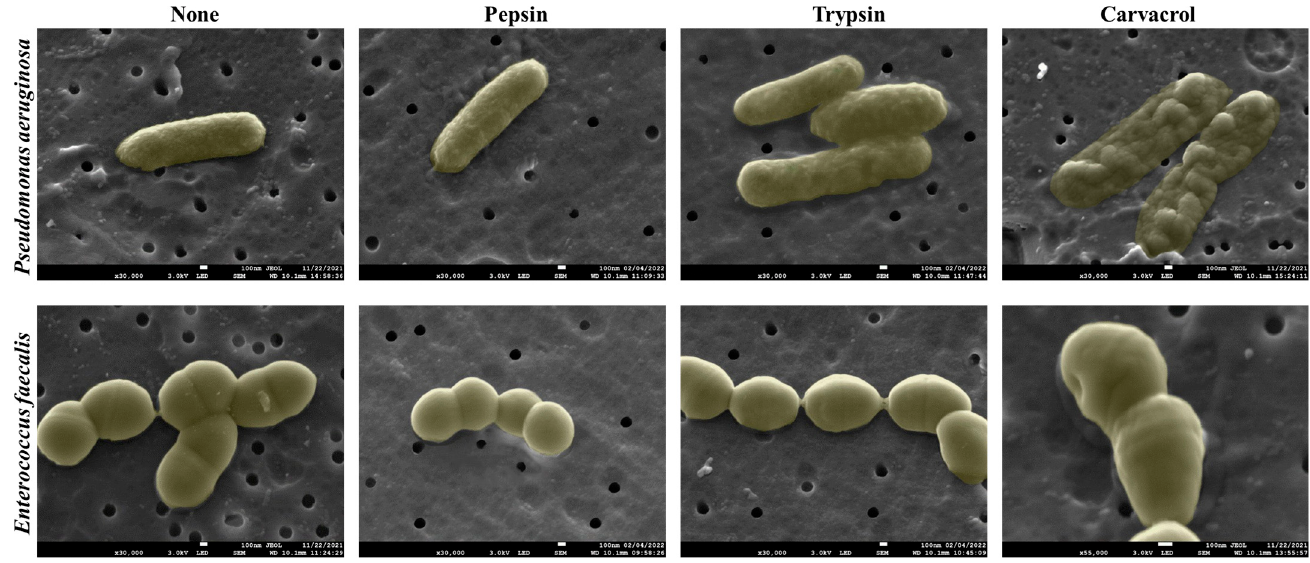
Figure 8. SEM micrographs of P. aeruginosa and E. faecalis biofilm cells after treatment with pepsin and trypsin at the minimal dispersive concentration (1 mg mL − 1 ) and carvacrol at the MICs. Control represents biofilm cells treated with tryptone salt.